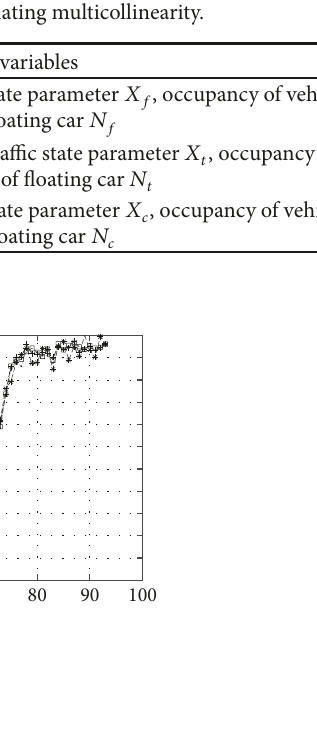
Figure 7: The estimated travel time.